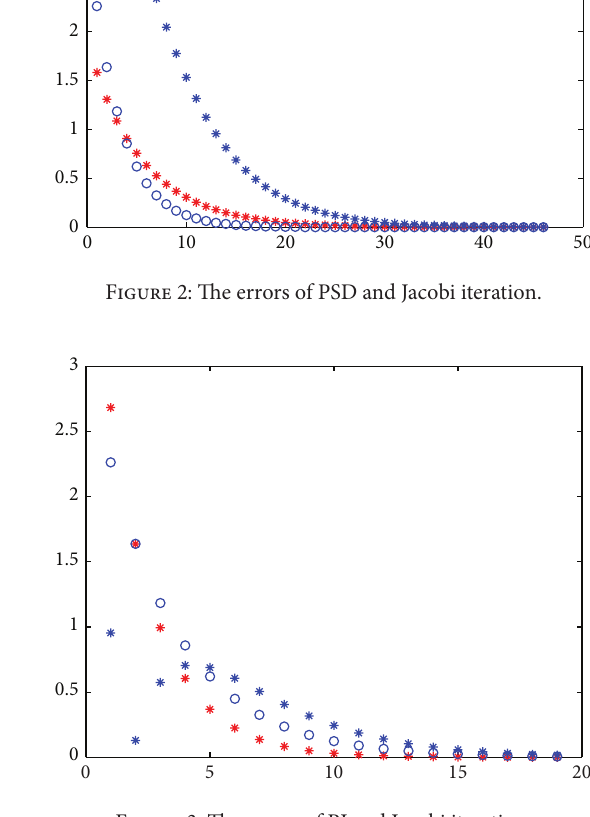
Figure 3: The errors of PJ and Jacobi